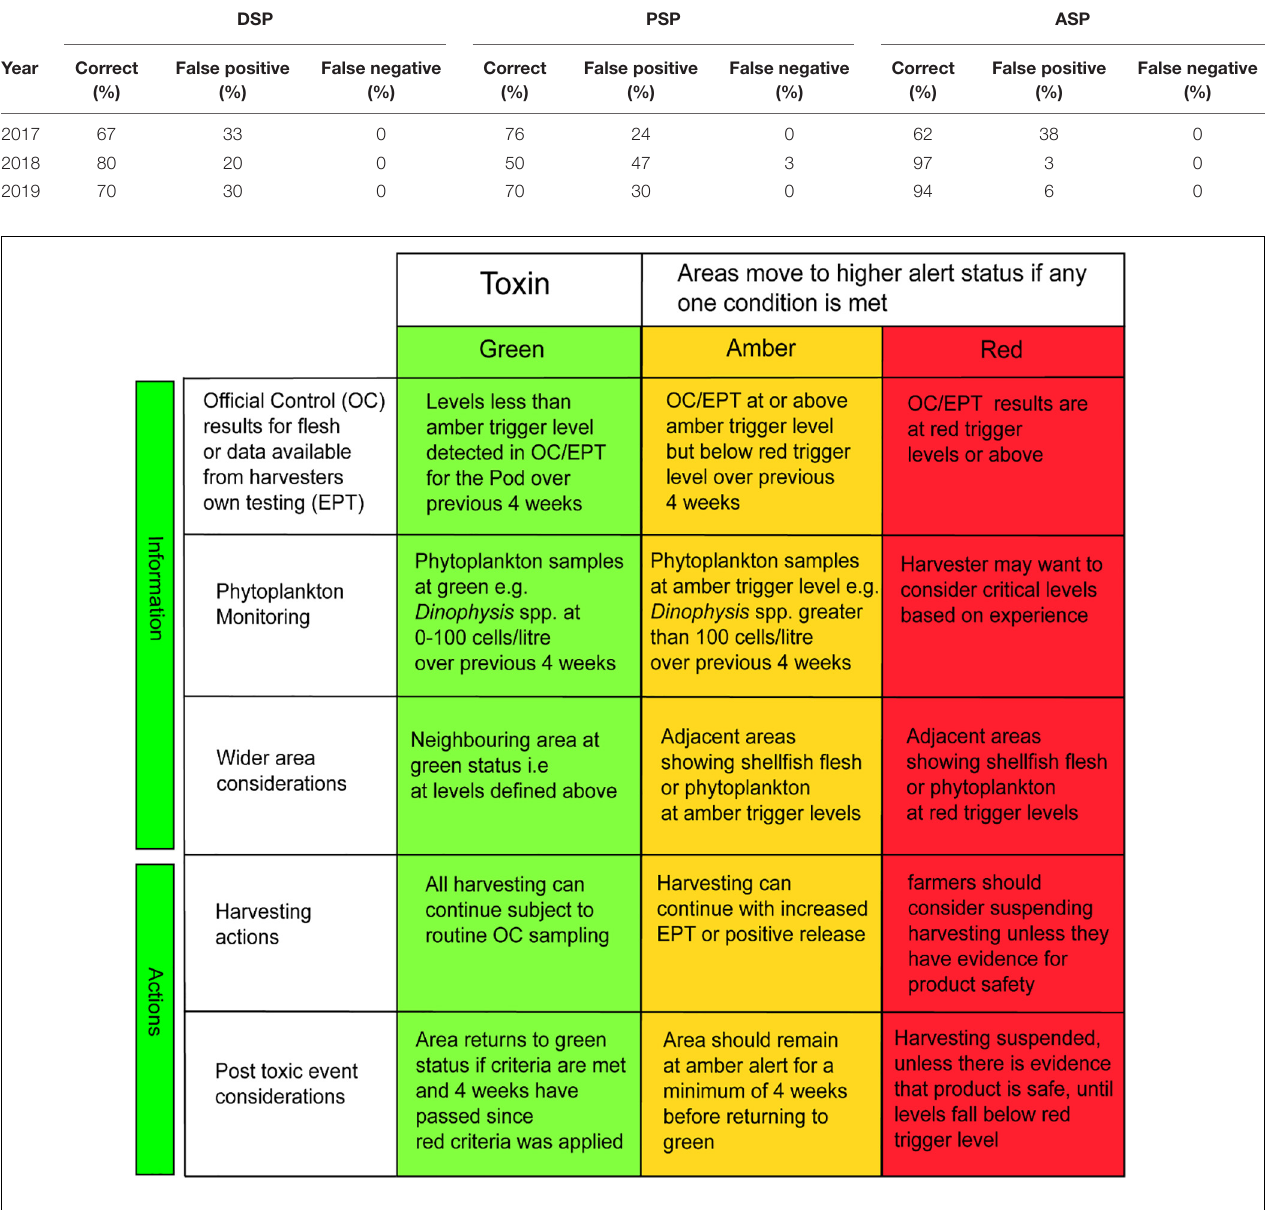
FIGURE 5 | The TLTG decision matrix: separate specific matrices are used for each toxin/phytoplankton group based on their relevant trigger levels. Each matrix is split into two sections. The top three rows describe the information that should be available to the shellfish farmers regarding phytoplankton and toxin analysis at their site and in adjacent sites. The bottom two rows describe the recommended actions taken following a toxic